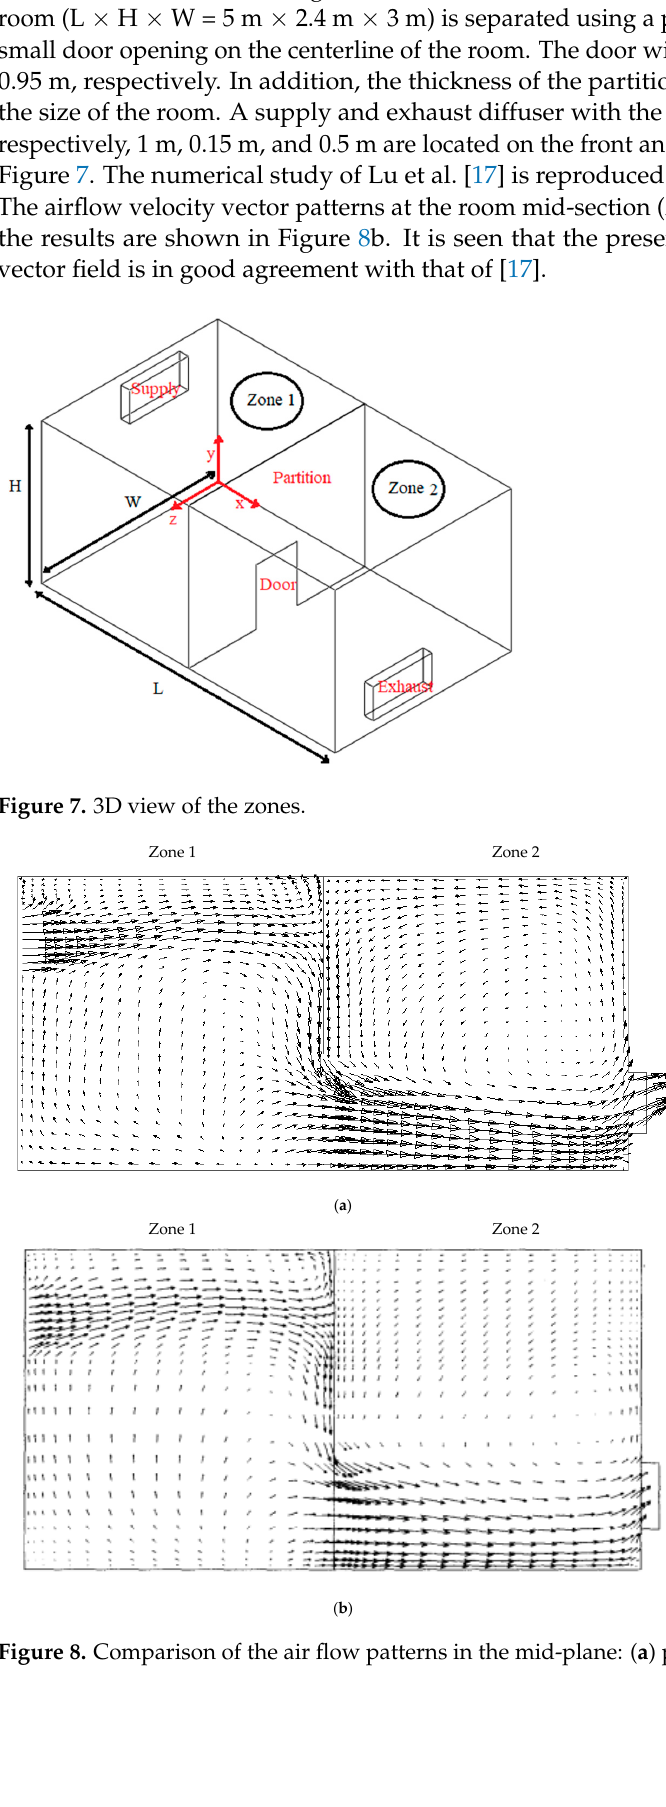
Figure 5. Validation of the present computational results for an evaporating 10 μ m droplet by com- parison with the data from [3].